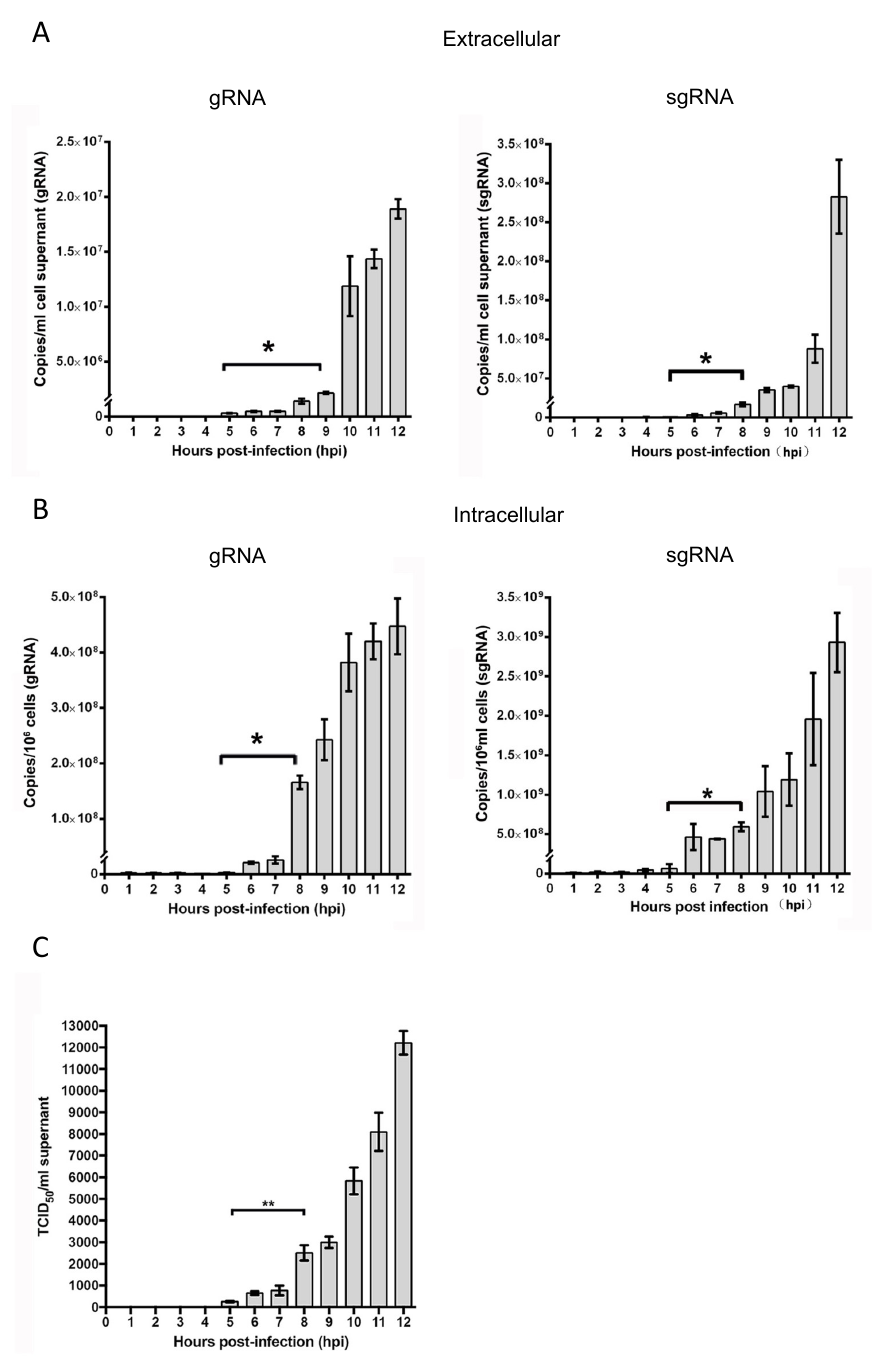
Figure 1. Determination of the growth kinetics and the time of one life cycle of porcine deltacoronavirus (PDCoV) infection in porcine kidney epithelial (LLC-PK1) cells. The amounts of extracellular gRNA and sgRNA ( A ), as well as intracellular gRNA and sgRNA ( B ) were determined by quantitative reverse-transcription polymerase chain reaction (qRT-PCR), respectively. Samples of supernatants and cells were collected at hourly intervals between 1 to 12 h post-infection. Viral titers were determined by end-point dilutions on fresh LLC-PK1 cells and calculated as TCID 50 per mL ( C ). Data represent mean values ± standard deviation (SD) of at least 3 replicates. Di ff erences in the RNA copies or virus titer were evaluated by t -test, Asterisks indicate significant di ff erences between the two groups, * p < 0.05; ** p < 0.01.